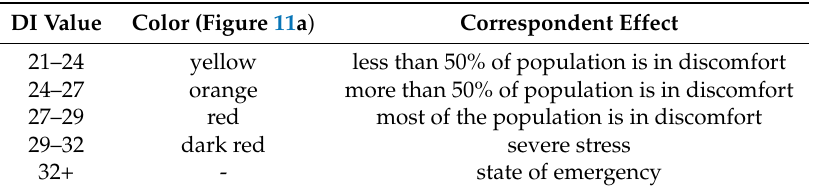
Table 2. Thresholds for DI, as defined by Buzan et al. [61]. The colors listed refers to the shading of Figure 11a; DI = 32+ is not colored as the value is not obtained in the test